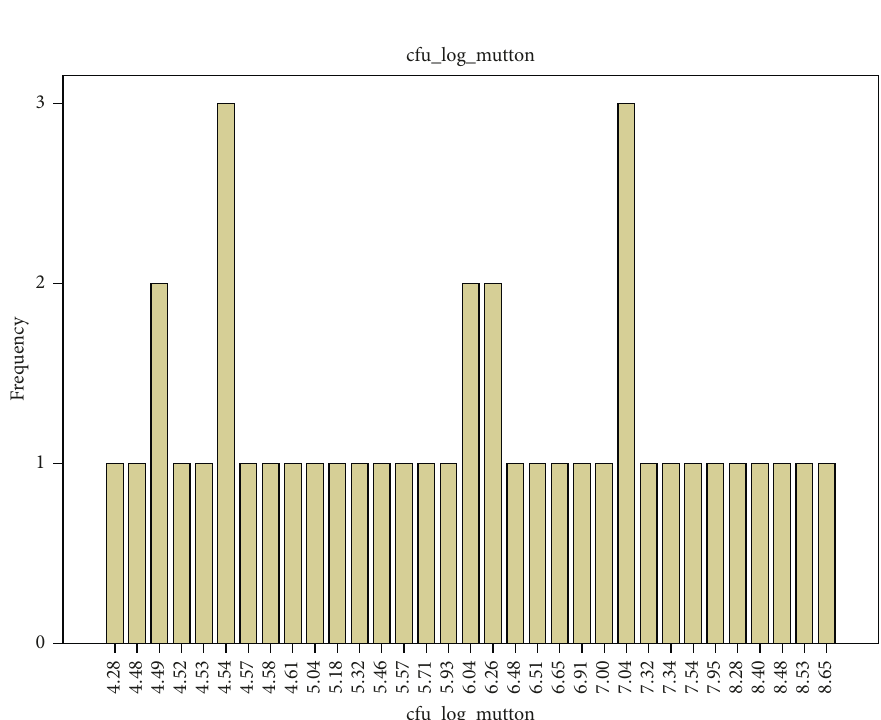
Figure 1: Total viable count in chicken.